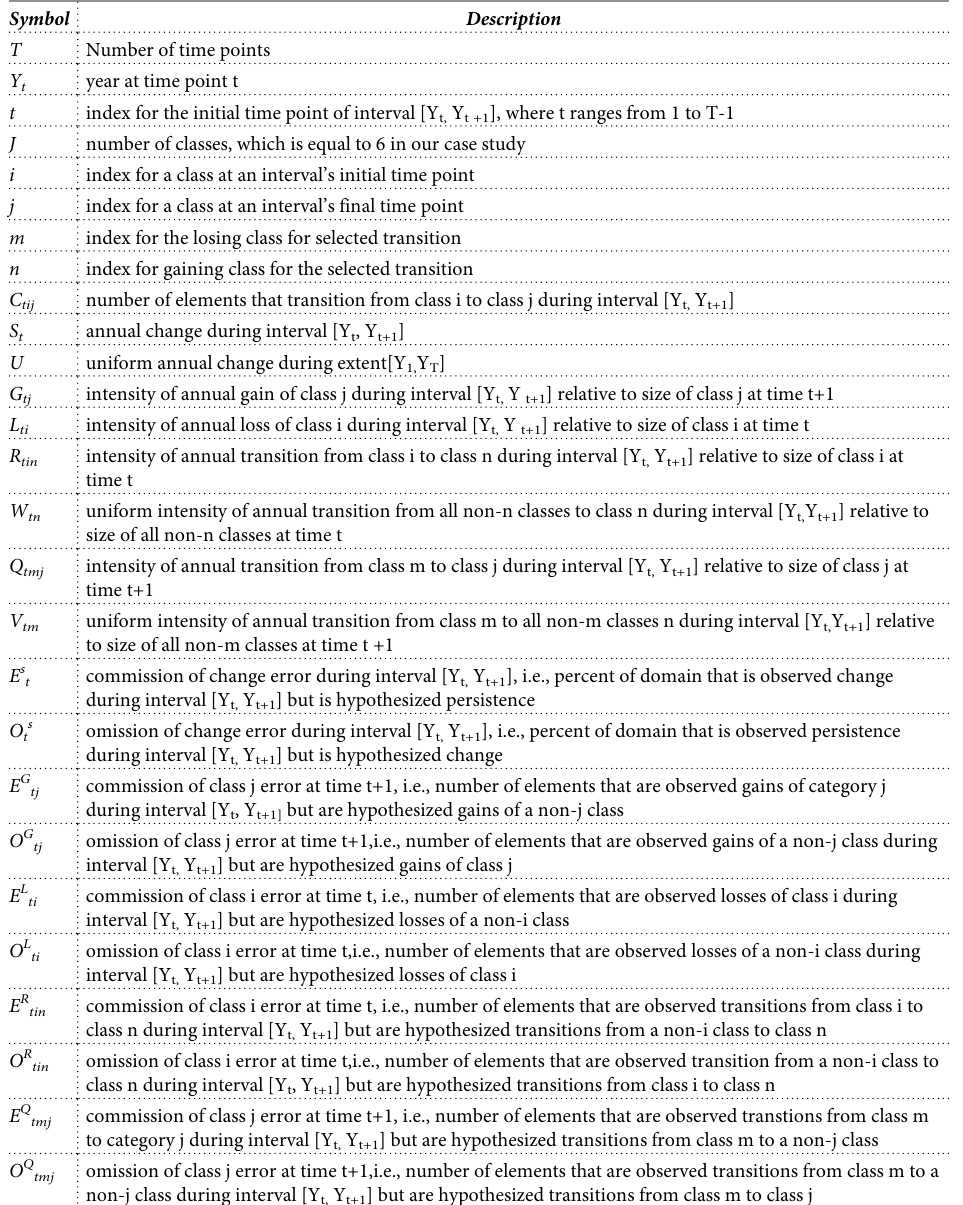
Table 2. Mathematical notation following Aldwalk and Pontius (2012, 2013). Symbol